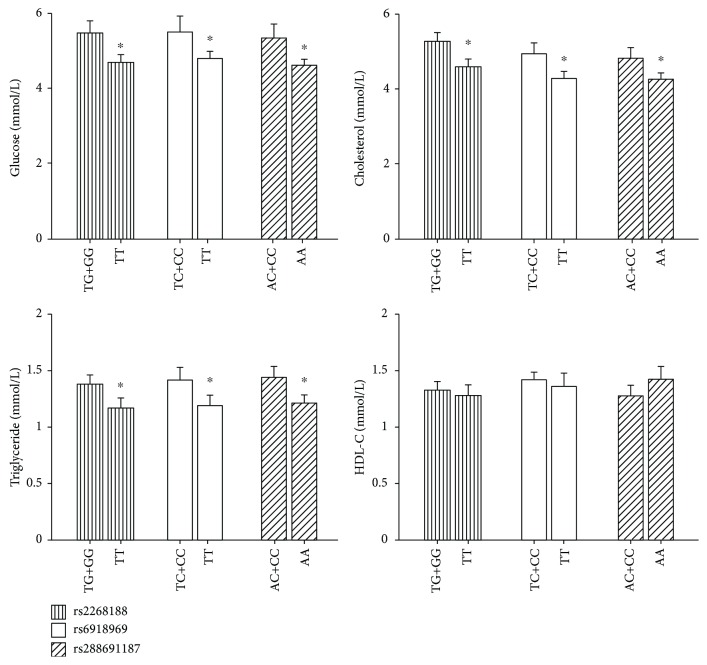
Effects of rs2268188, rs6918969, and rs28869187 on metabolic parameters. The effects were analyzed with covariates gender, age, and body mass index (BMI) in participants with normal glucose regulation under a dominant model. Values are expressed as the means ± SD. ∗Statistically significant at P < 0.05.